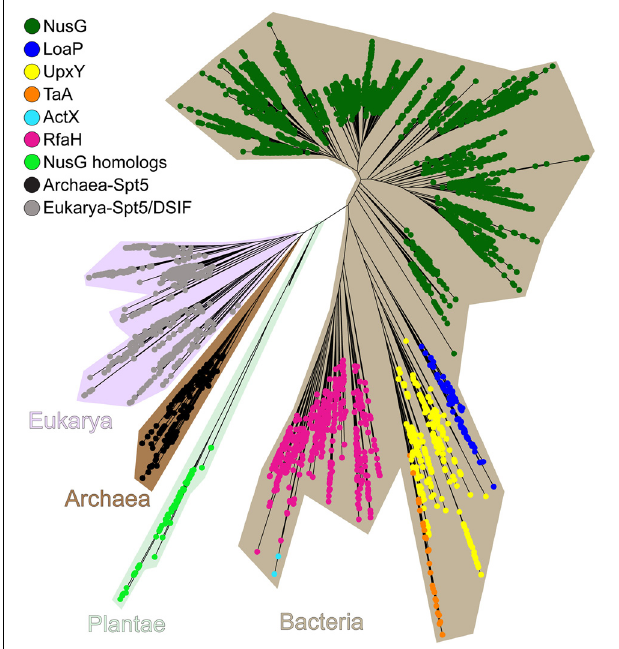
FIGURE 11 | The maximum-likelihood phylogenetic tree of NusG-like proteins. Plantae is an artificial group used solely for brevity.